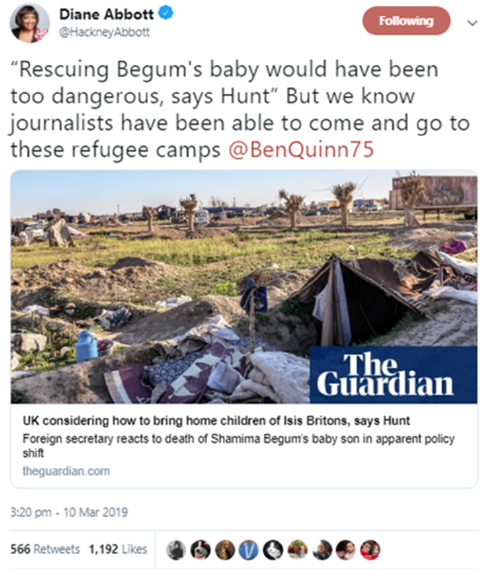
Figure 6. Tweet from Shadow Home Secretary Diane Abbott, 10 March 2019.